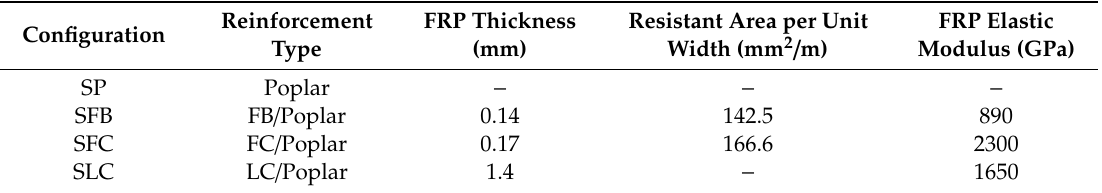
Table 2. FRP properties for each particular specimen.